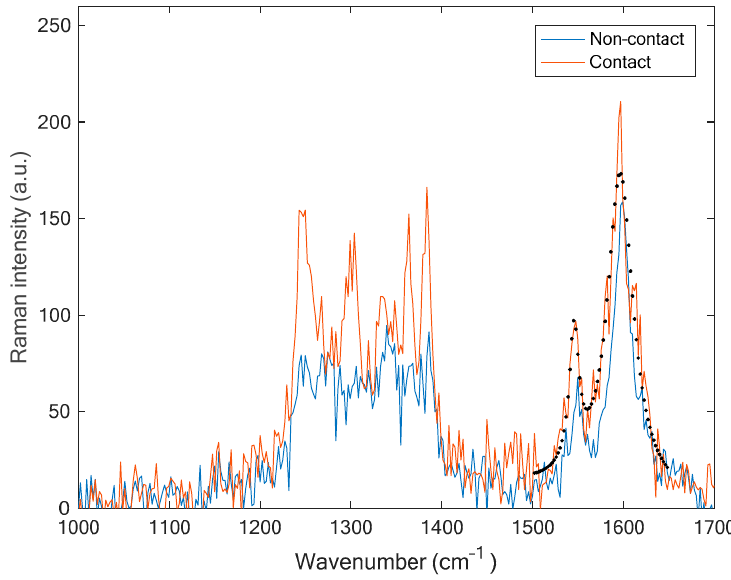
Figure 10. Tip-enhanced Raman scattering spectrum of a single-wall carbon nanotube with the silver tip in close vicinity to the surface. The fitting for the G − and G + is indicated with dots.